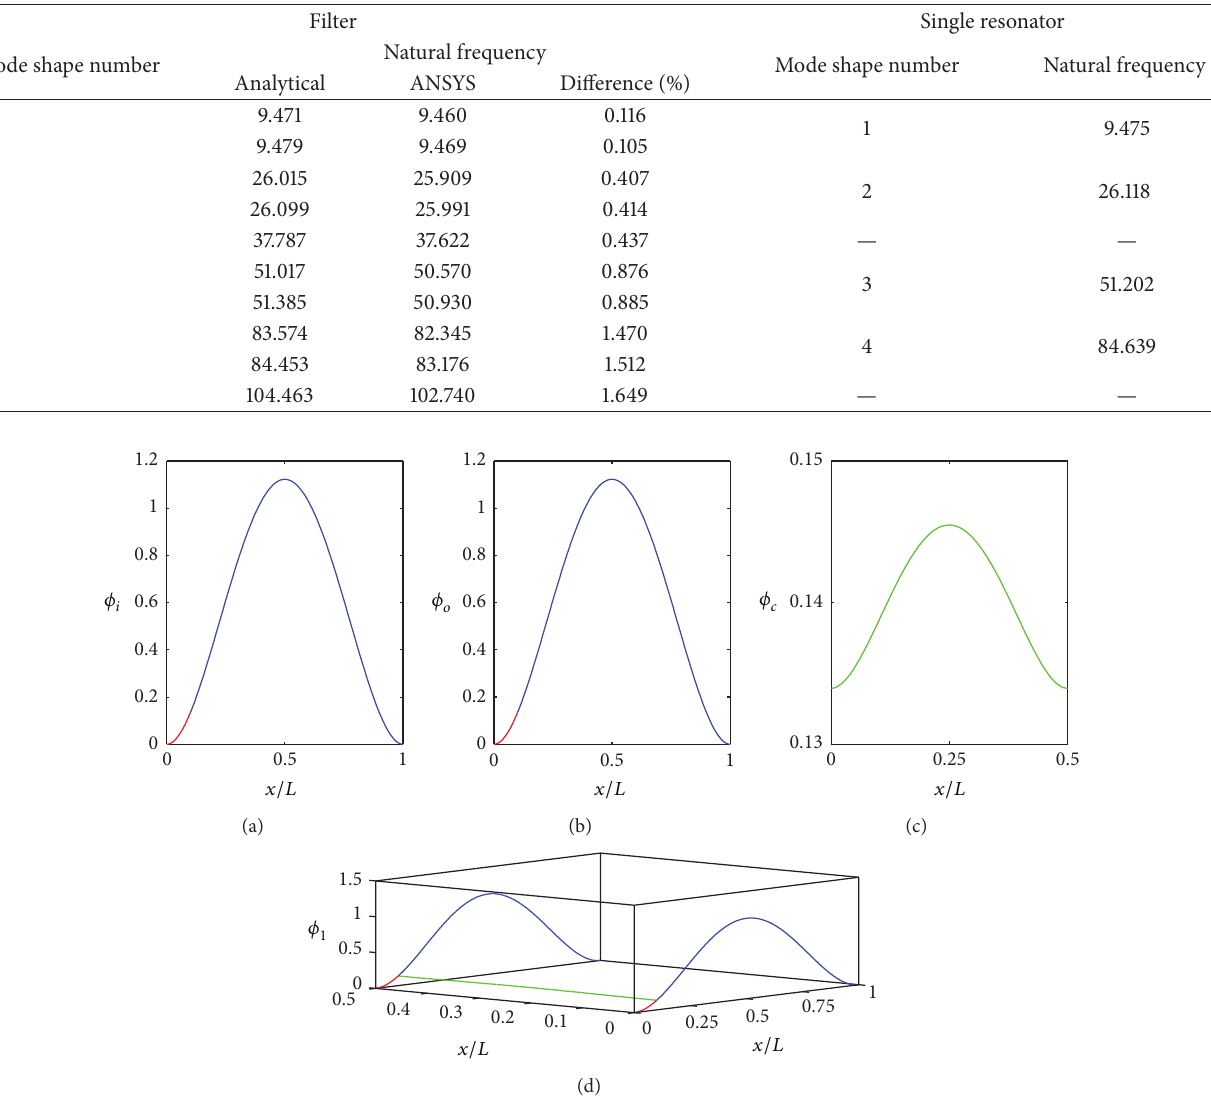
Figure 2: First mode shape of the filter: (a) input, (b) output, (c) coupling beams, and (d) combination of (a), (b), and (c).